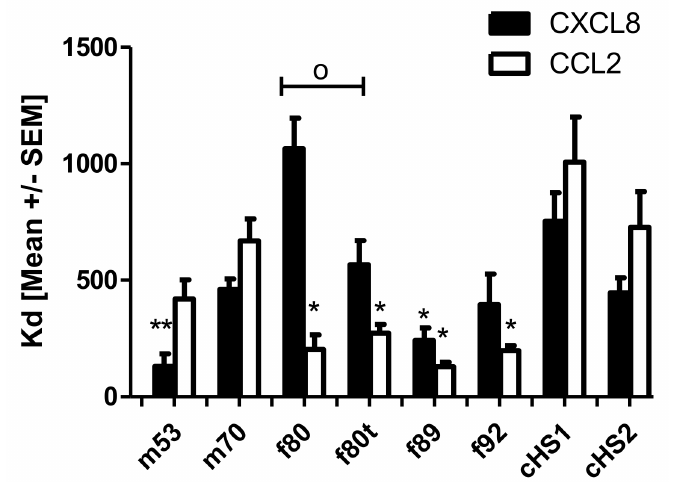
Figure 4. Isothermal fluorescence titration of CXCL8 and CCL2 with commercially available HS derived from porcine compared with HS prepared from lung tissue of different humans. With f for females, m for males, t for tumor lobe, and the number for the patient’s age. Data are shown as mean ± SEM of three measurements; groups were compared with the corresponding titration using Student´s t -test with * cHS1 or o between normal versus tumor lung lobe; */ o p < 0.05, ** p <